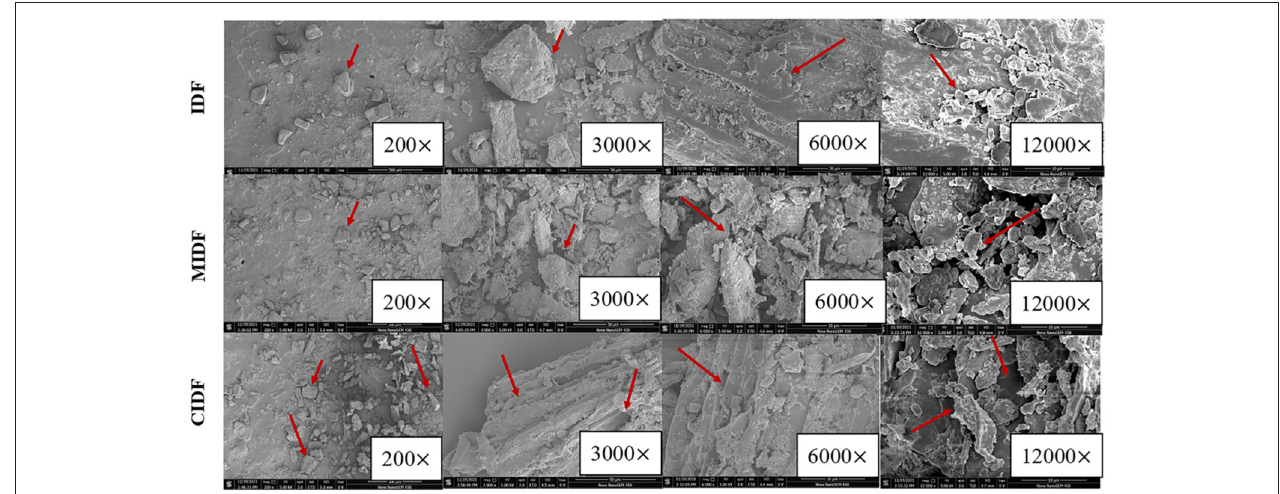
FIGURE 2 | SEM of insoluble dietary fibers with the magnification of 200 × , 3,000 × , 6,000 × , and 12,000 ×